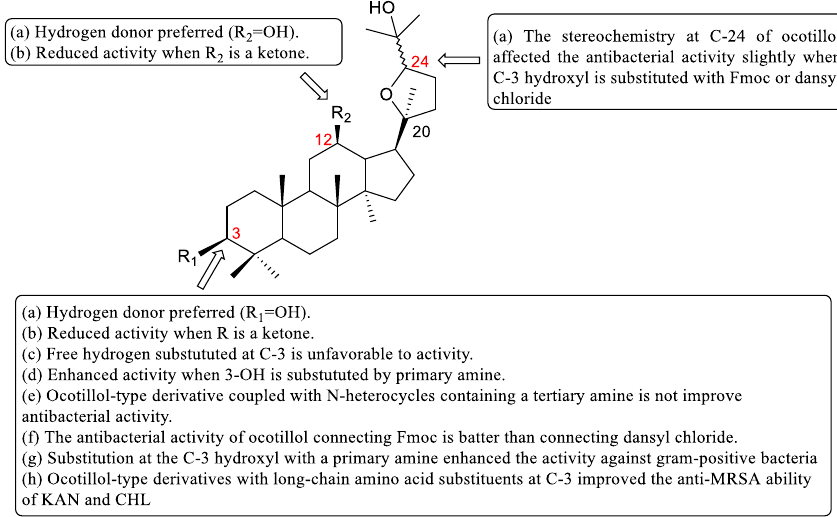
Figure 4. Structure – activity relationships (SARs) of ocotillol-type